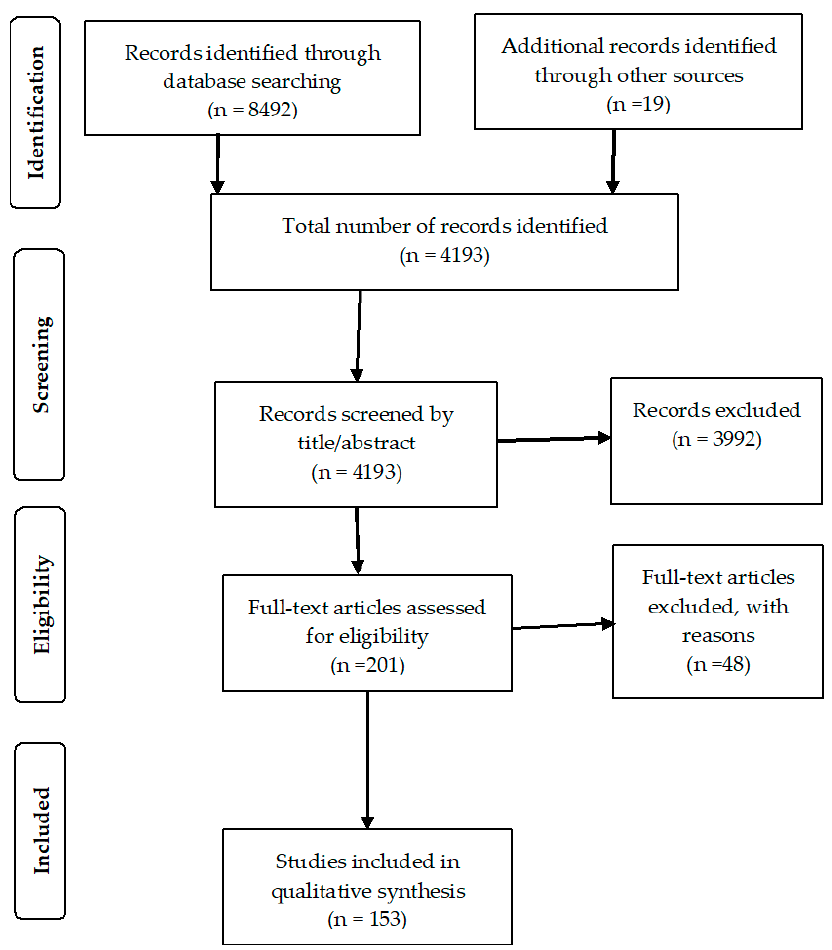
Figure 1. PRISMA flow diagram of the article selection process.